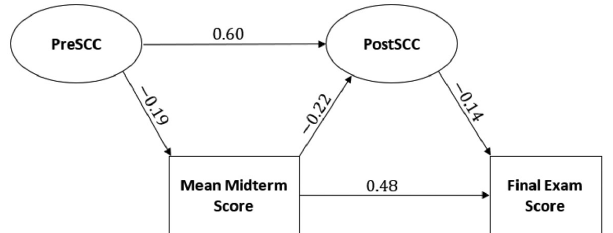
FIG. 5. Structural equation model of SCC and exams and the standardized path estimates (standardized including all